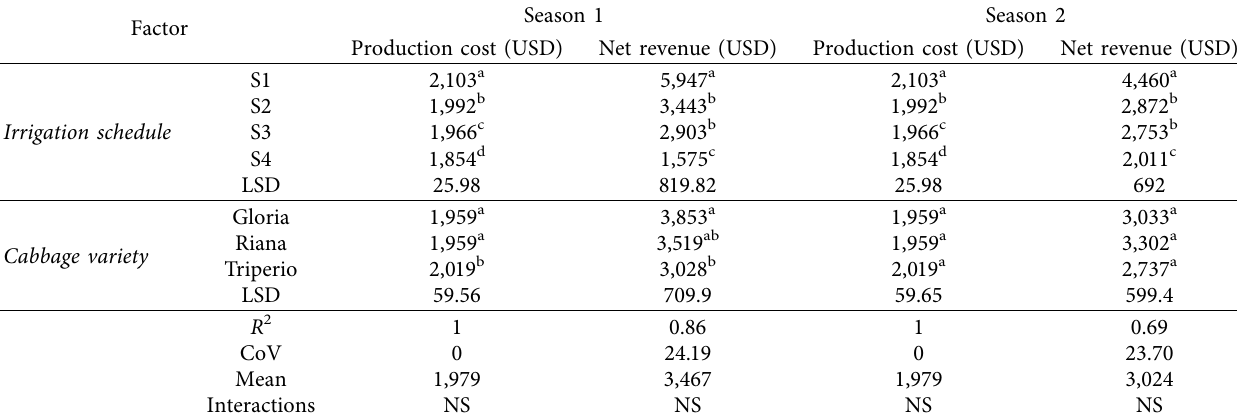
Table 3: Economic analysis for drip irrigated cabbage varieties over different irrigation